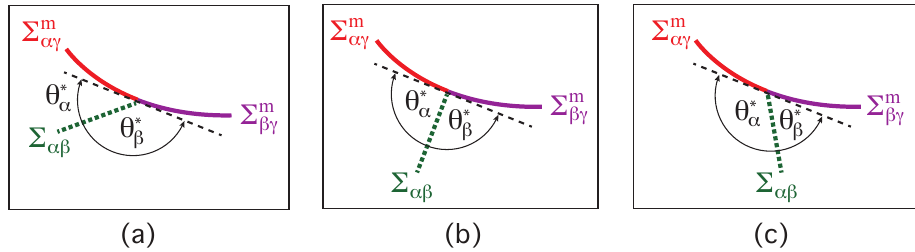
Figure 15. Intrinsic contact angles θ ∗ α and θ ∗ a smoothly curved membrane segment: ( a ) Partial dewetting of the β droplet with θ ∗ α < θ ∗ limit of zero θ ∗ α corresponds to complete dewetting from the β phase; ( b ) Balanced adhesion with θ ∗ α = θ ∗ ; and ( c ) Partial wetting by the β droplet with θ ∗ α > θ ∗ β complete wetting by the β phase. The dashed black line represents the common tangent plane of the two membrane segments at the contact line which implies θ ∗ α + θ ∗ surface segments and tensions as in Figures 9 and